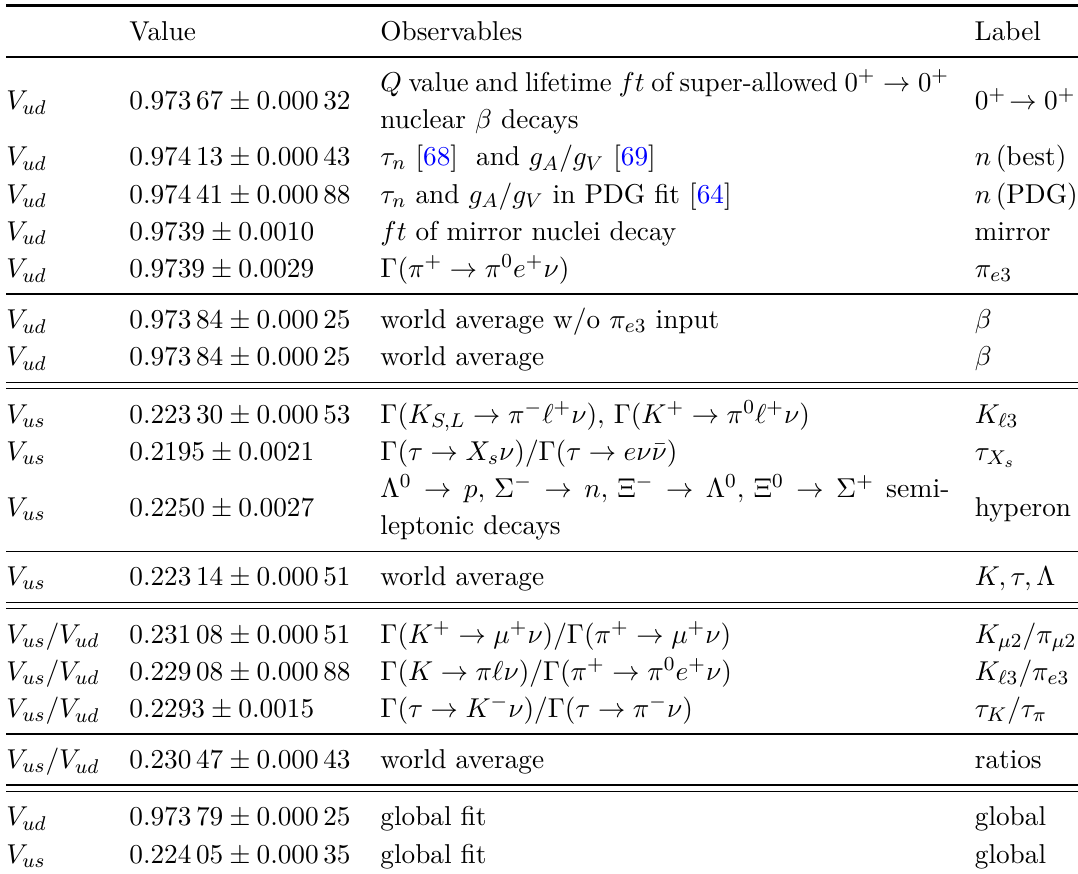
Table 1 . Up-to-date extractions of the CKM elements needed to test the first-row unitarity. is inflated by scale factors which come from inconsistencies in the data. By using the single most precise result for the neutron lifetime τ n [68] and the nucleon isovector axial charge g /g | V | . 97413(43) is possible [19]. Combining A V [69], a better determination of ud n (best) = 0 | V | | V | | V | | V | mirror , and π e 3 , we obtain a weighted average ud ud n (best) , 0 + → 0 + , ud ud